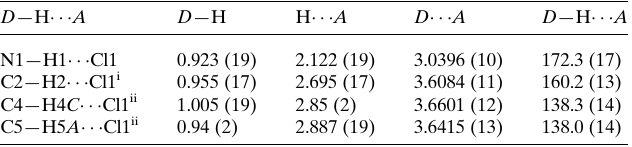
Table 1 Hydrogen-bond geometry (A˚ , (cid:6) ).